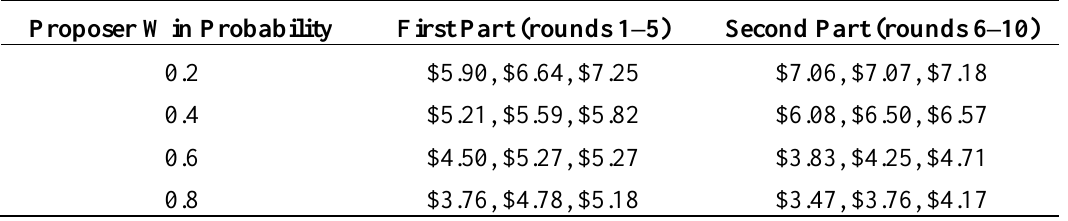
Table 2. Average Responder Counter Demands by